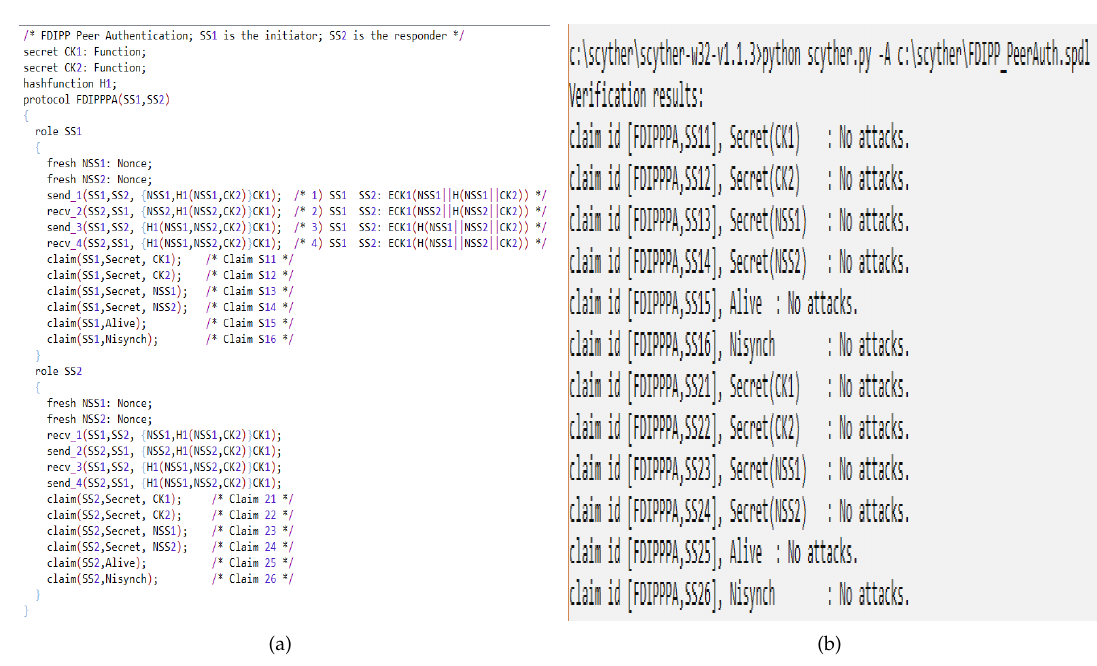
Figure 6. FDIPP Peer Authentication Analysis. ( a ) Peer Authentication analysis input. ( b ) Peer Authentication analysis